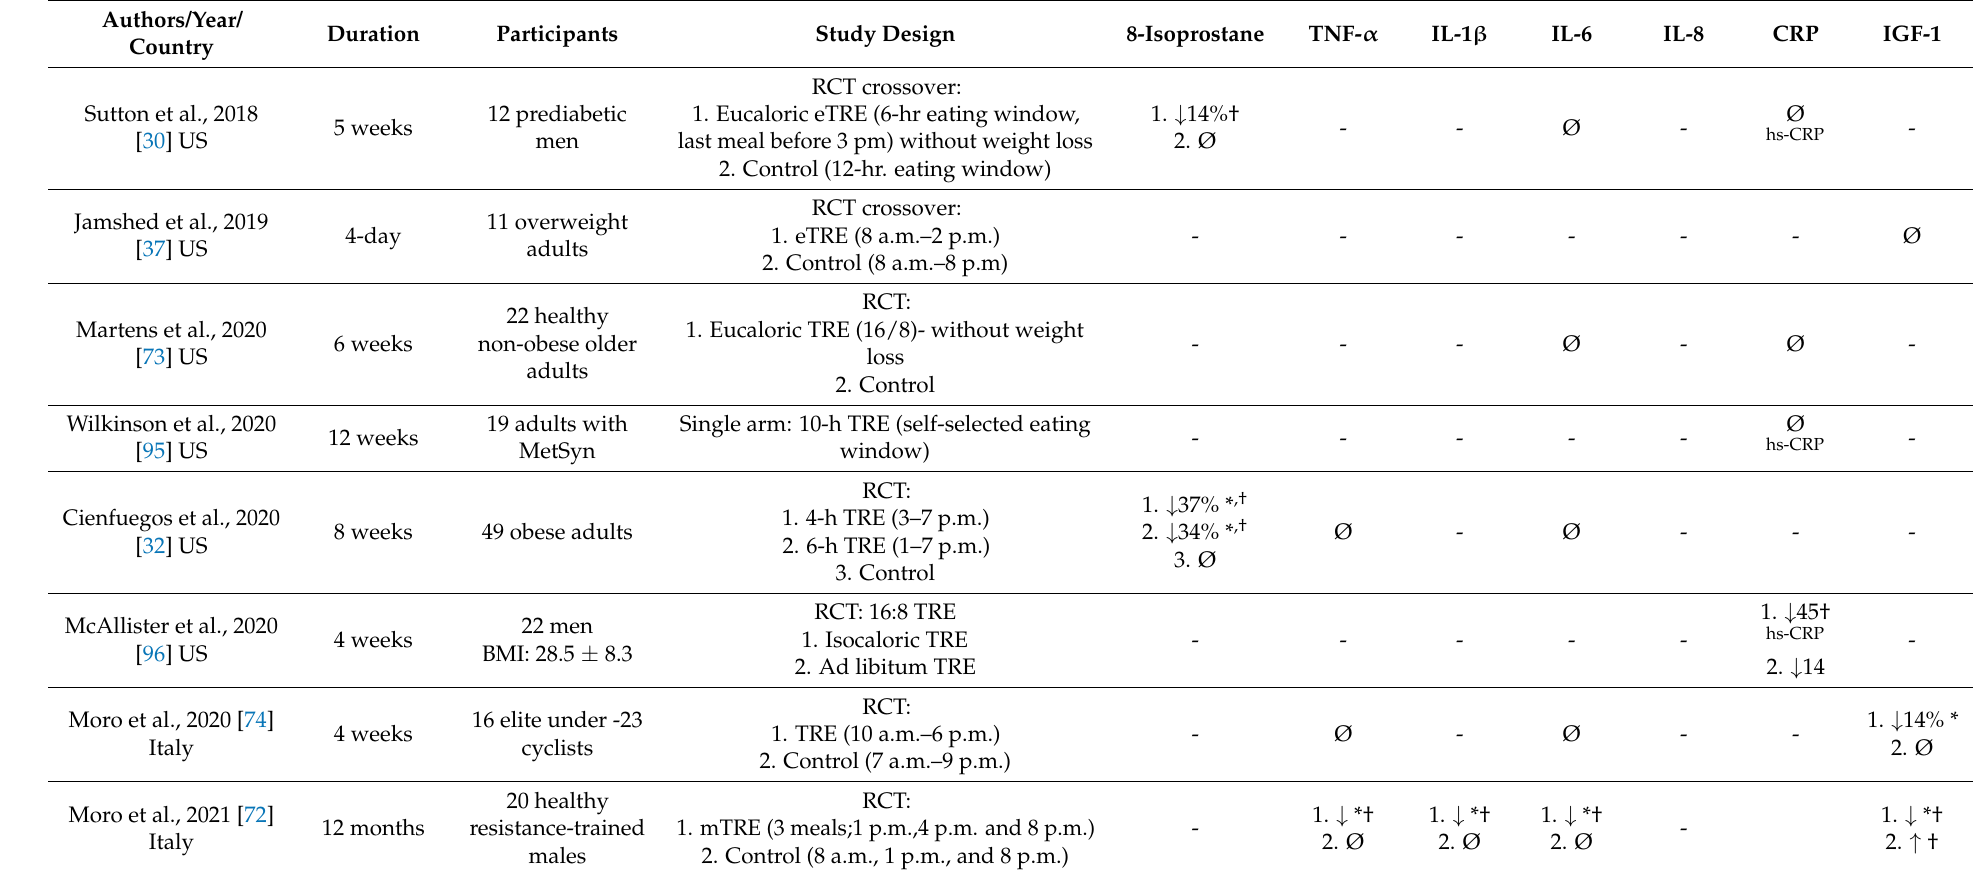
Table 2. Summary of clinical trials on the impact of time-restricted eating (TRE) on inflammatory markers and oxidative